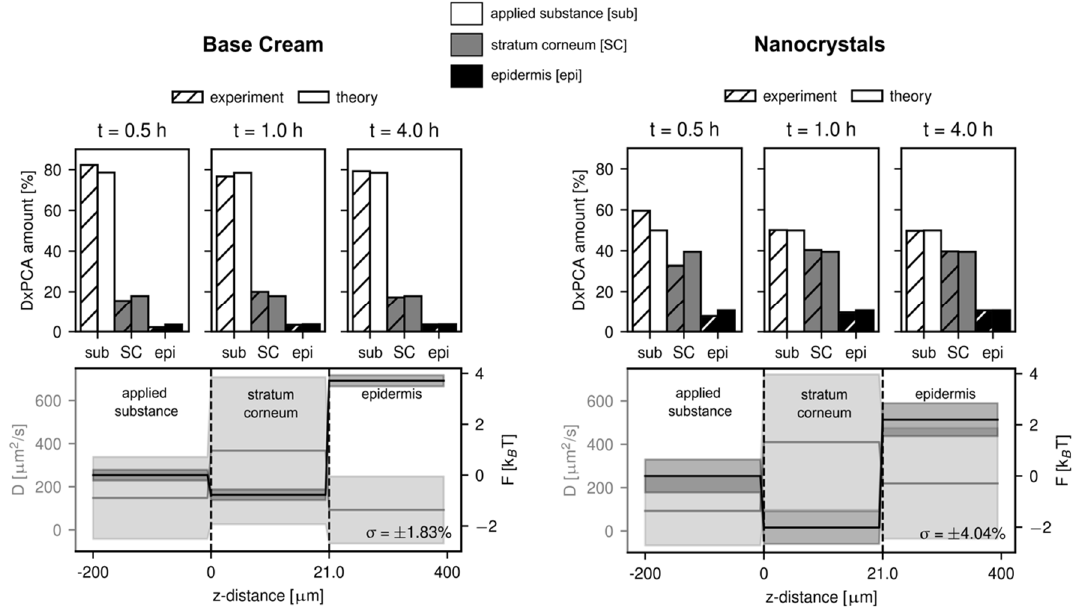
Figure 5. Results of the numerical analysis for the penetration of DxPCA in the two formulations in the case of healthy skin. A root mean squared error of below 5% is obtained for all analyses. An increased partitioning of DxPCA into the SC is observed for the nanocrystal formulation, apparent in the lower energy value in the SC for the nanocrystal suspension (a partition coefficient of K (SC/sub) = 7.4 was obtained, compared to K (SC/sub) = 2.2 for the base cream formulation). Shaded areas indicated the estimated error for the diffusion constant and free energy.